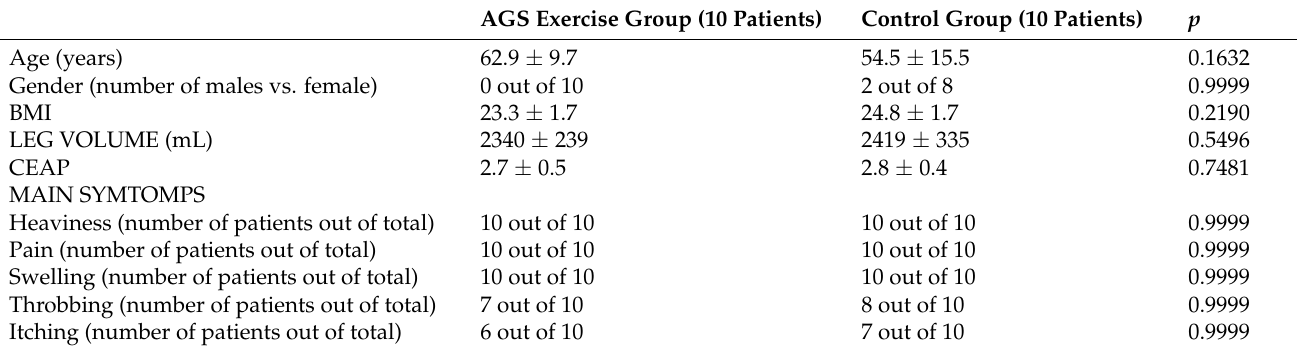
Table 2. Baseline clinical and demographics characteristics of the study population.